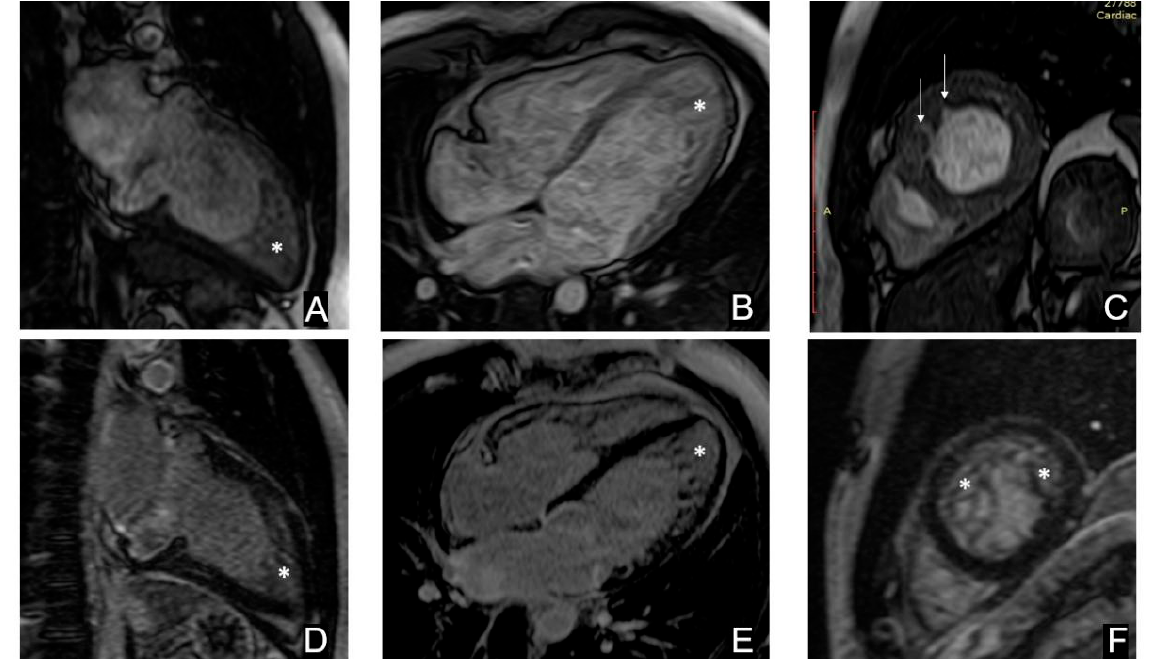
Figure 2. ( A – C ) The proband’s cardiac magnetic resonance imaging (cMRI) in cine mode, SSFP sequence: ( A ) long axis 2-chamber images, ( B ) long axis 4-chamber images, ( C ) short axis images at the level of the middle segments. ( D – F ) DE (delayed enhancement) cMRI images, inversion recovery (IR) sequence with suppression of the signal from the normal myocardium. No areas of contrast enhancement were detected, which indicates the absence of areas of intramyocardial fibrosis, scar- ring or inflammatory myocardial damage. * indicates a layer of non-compact myocardium in the apical segments, → indicates clefts in the middle anteroseptal segment.